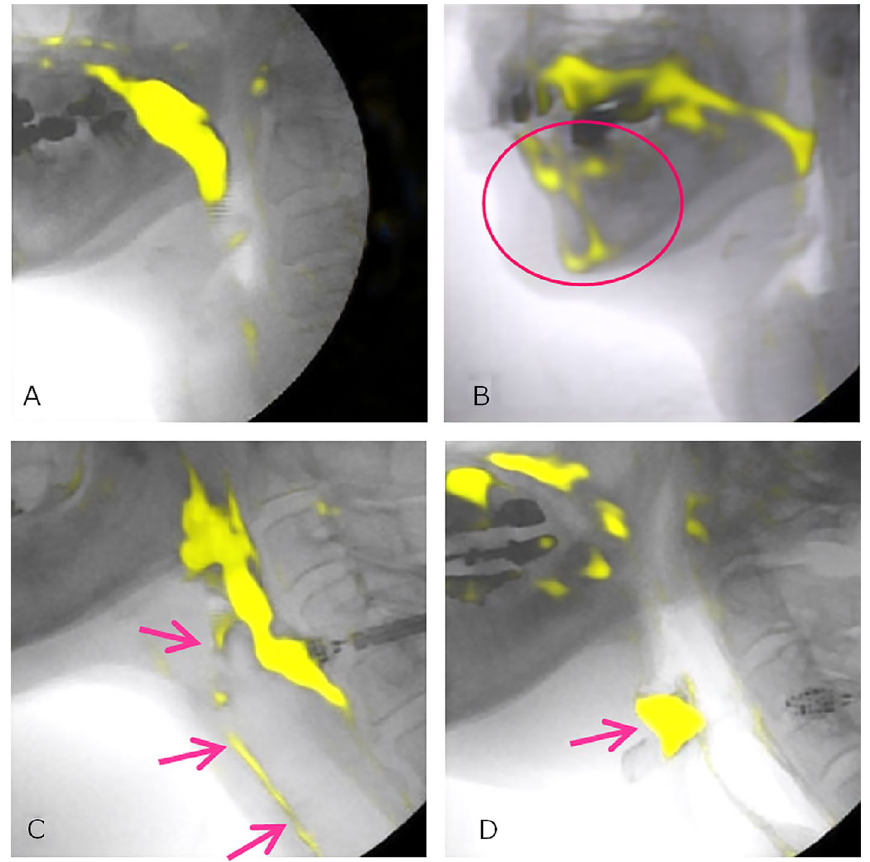
Figure 1. Examples of contrast bolus segmentation using deep learning ( A ) The contrast bolus was accurately predicted. ( B ) The contrast bolus was not accurately predicted. This may have been caused by false-positive detection of the metals and chin area. ( C ) The contrast bolus, including area showing aspiration swallowing, was accurately predicted. ( D ) The retention of contrast medium in the pyriform sinus was